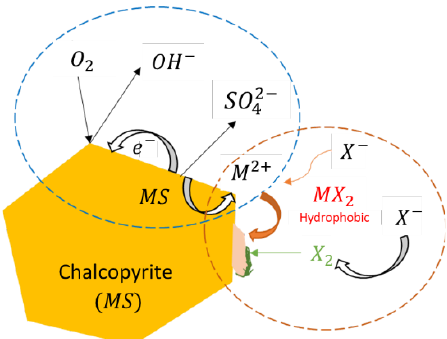
Figure 13. Schematization of xanthate chemical adsorption and hydrophobic coating of a chalcopyrite mineral particle (adapted from Yepsen [44]).